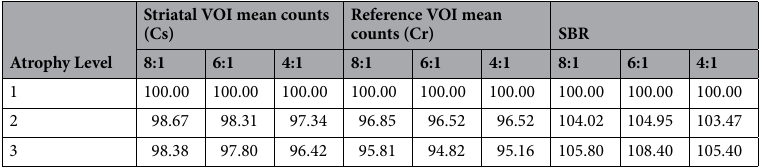
Table 2. Rate of change in values due to brain atrophy. Rate of change for each value with reference to atrophy Level 1. All values increased with the increase in the degree of brain atrophy.